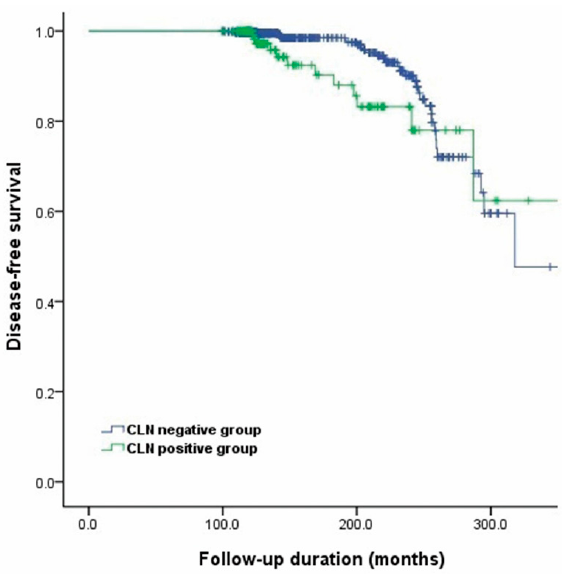
Figure 2. Kaplan–Meier curve for disease-free survival ( p = 0.065). Abbreviations: CLN: Central lymph node. Table 2. Cox proportional hazard analysis of variables predicting recurrence after less than total thyroidectomy.